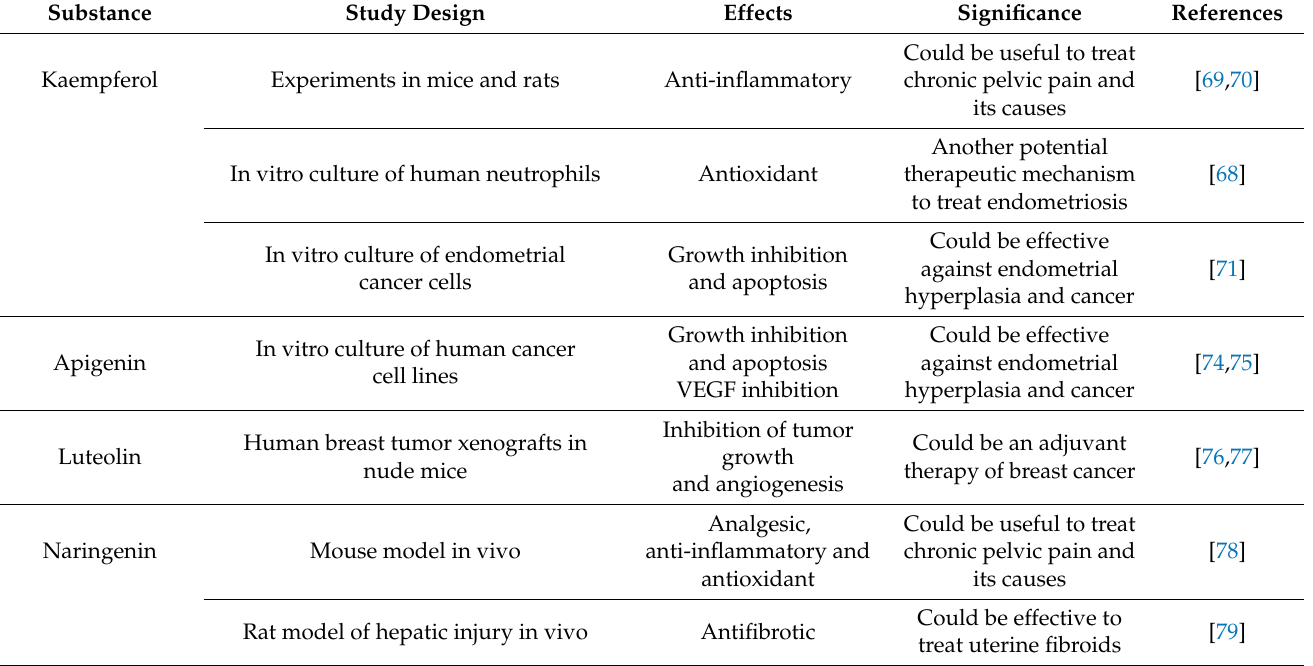
Table 1. Effects of phytoprogestins that suggest their potential to treat women’s